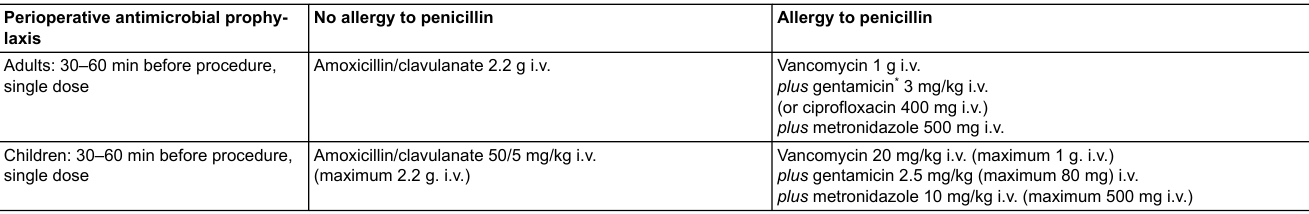
Children: 30–60 min before procedure, single dose